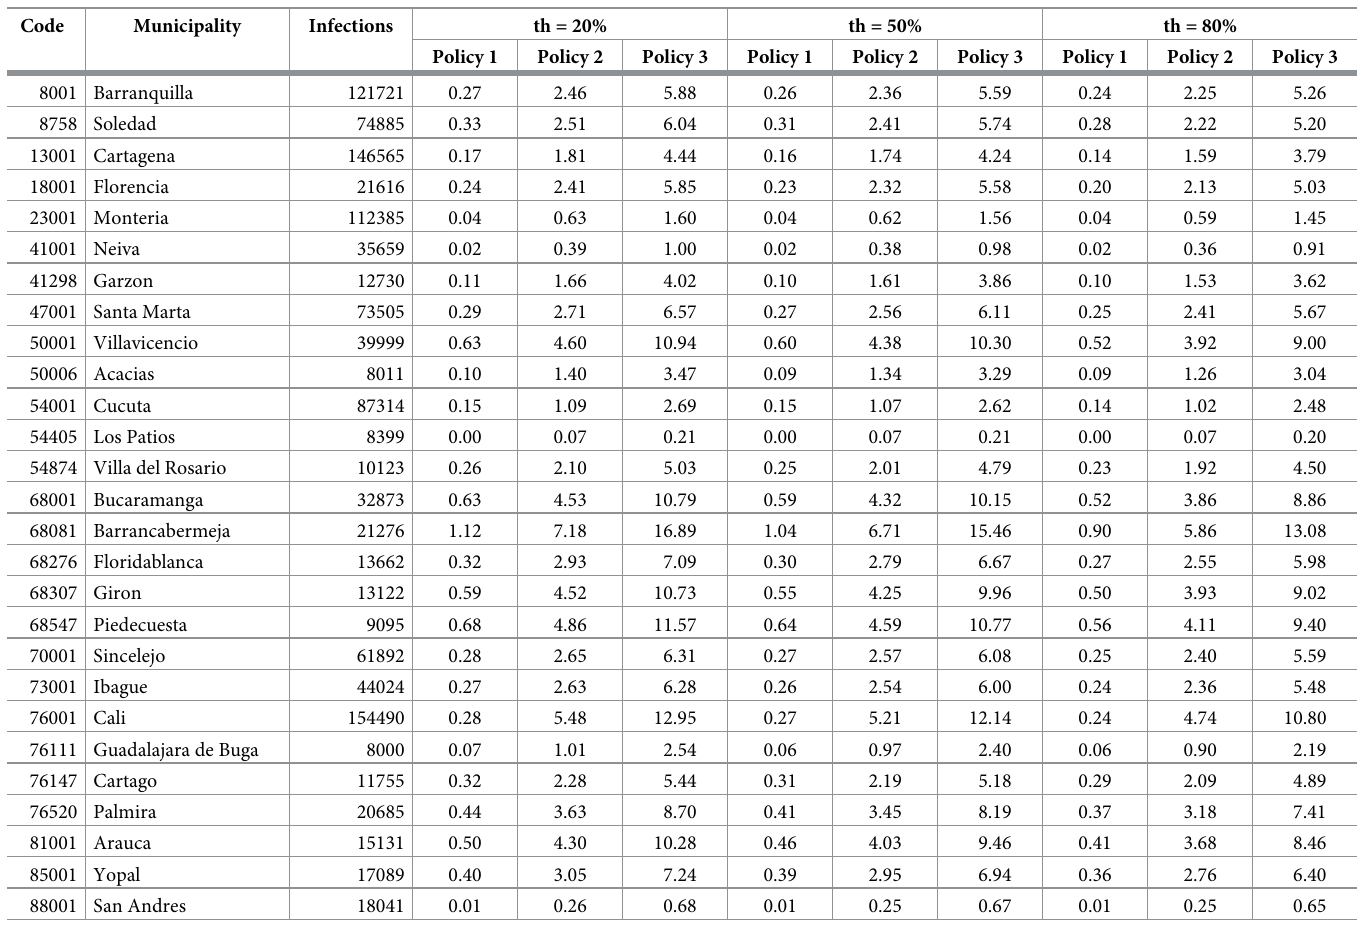
Table 7. Percentage of reduction of ZIKV infections by